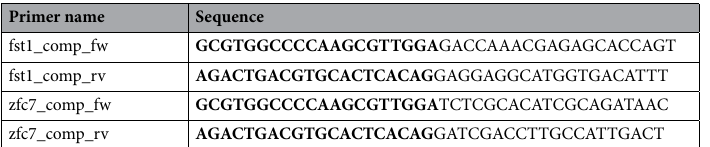
phleomycin resistance cassette a promotor and CDS insert flanked by HindIII and BamHI, an intron and a 432 bp sc3 terminator. The fragments were assembled with pPV008 digested with HindIII and BamHI with gibson assembly. This resulted in complementation plasmids pPV024 and pPV026 for fst1 and zfc7, respectively. Strains were complemented as described previously and candidate complement strains were selected based on their ability to recover the wild type fruiting phenotype 5 .